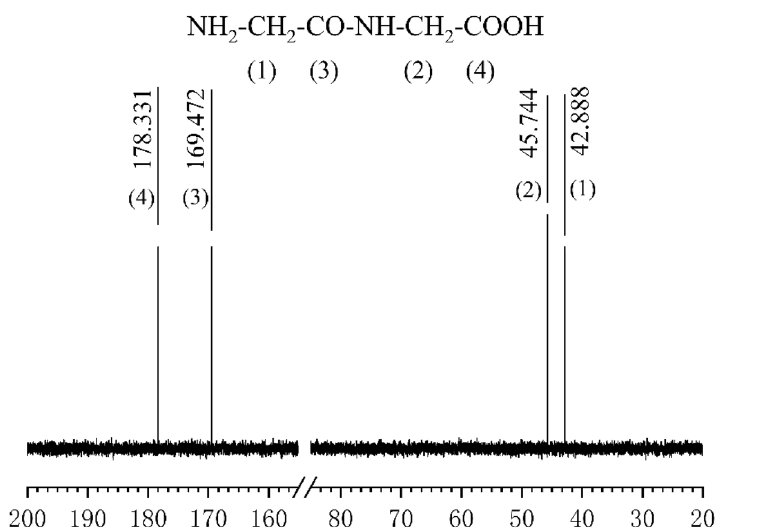
Figure 6. 13 C NMR spectrum of GlyGl before